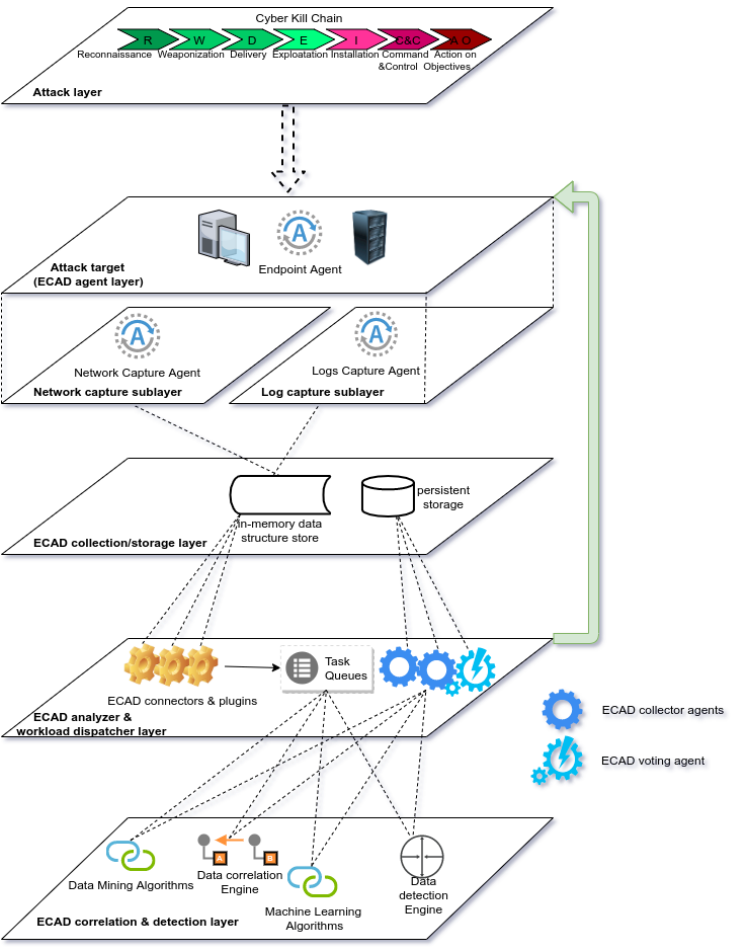
Figure 2. The four-tier architecture of